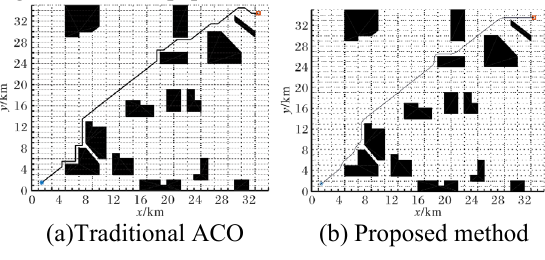
Figure 6. Comparison of traditional ant colony algorithm and the proposed algorithm under static environment